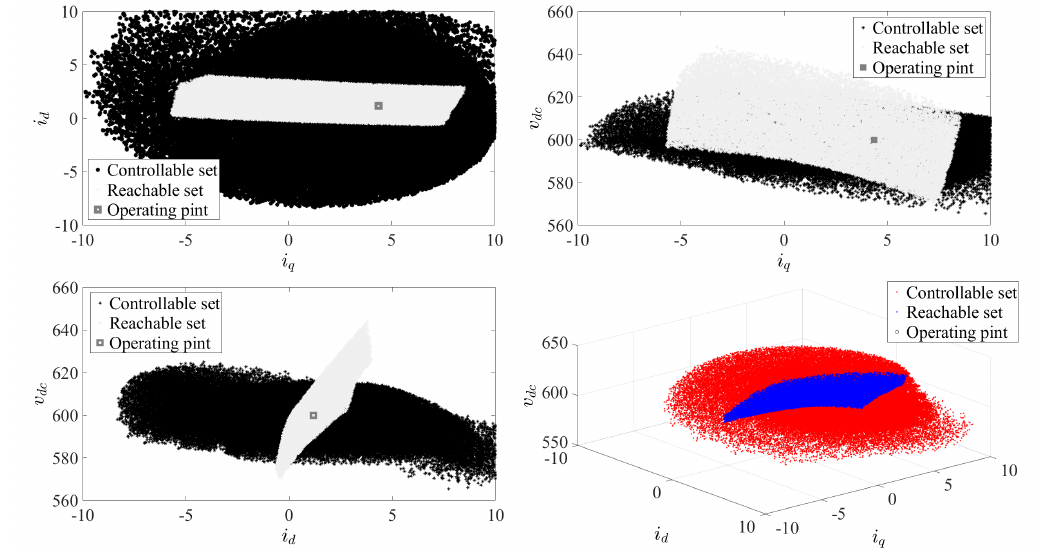
Figure 4. Reachable set from x 0 at t = 50 ms and controllable set to x 0 in t = 50 ms for the TLSC